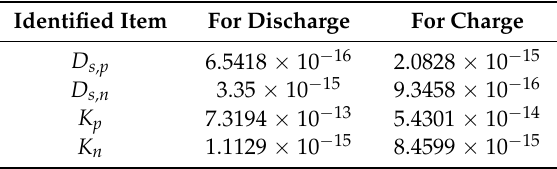
Table 3. Identified items for Navy-over-discharge (OD) battery.